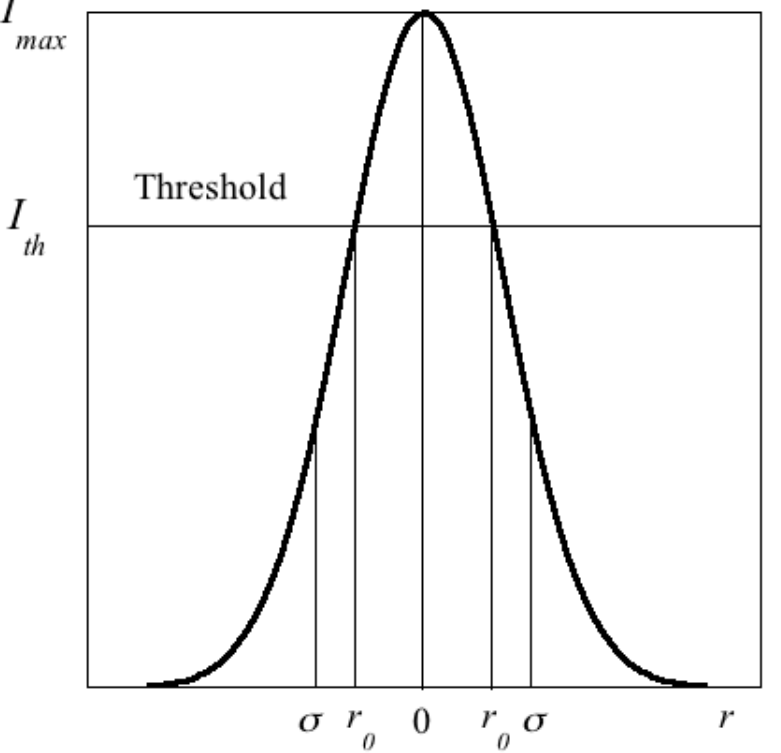
Figure 9. Scheme of the spatial distribution of the pumping intensity in a Gaussian spot. Lasing is only possible within a circle of radius r o . Table 4. Experimental threshold energies E th and slope efficiencies η for the different laser cavities studied. In parenthesis the theoretical E th values according to Equation (9).